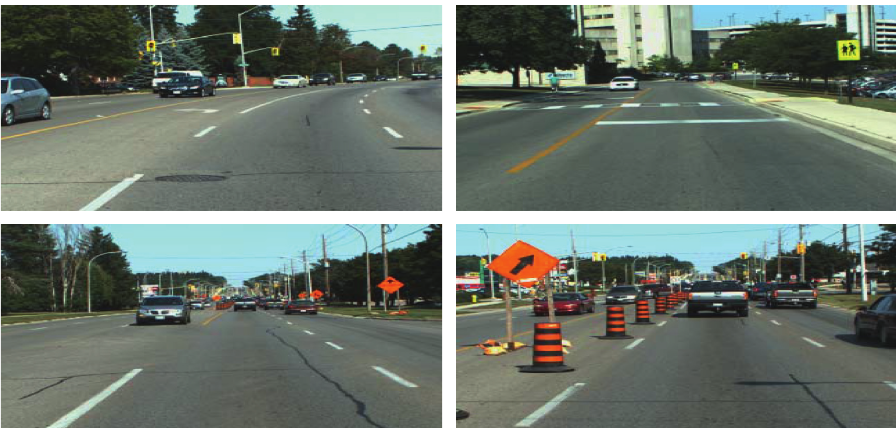
Figure 2: Examples of images from the RoadLab dataset.